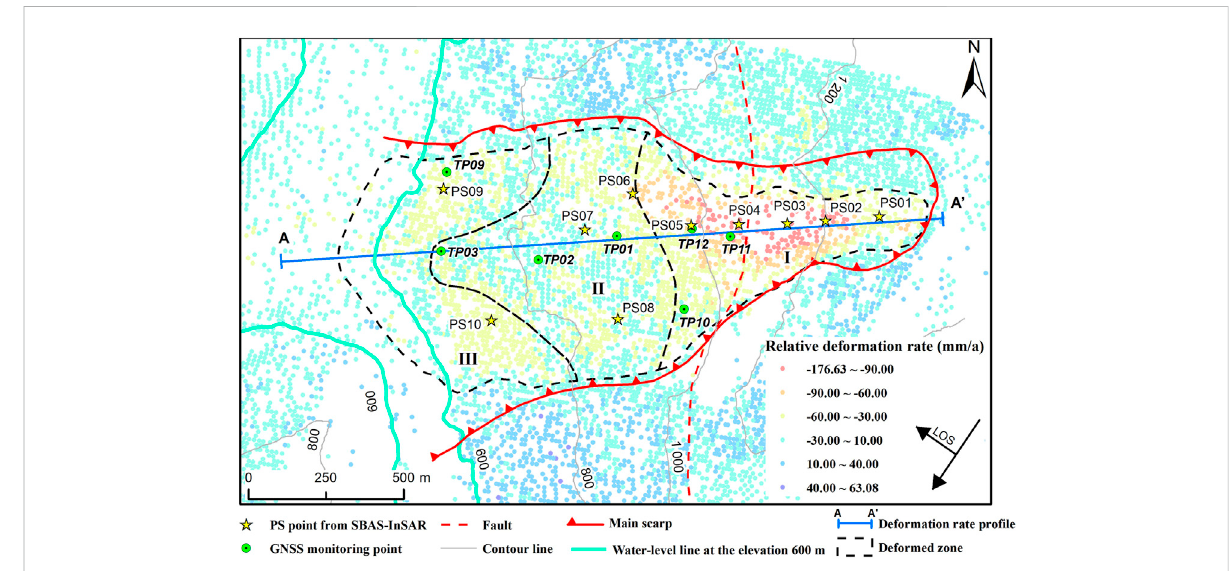
FIGURE 7 SBAS-InSAR results of the NLJL, the locations of the selected 10 PS points from SBAS-InSAR, and the locations of GNSS.